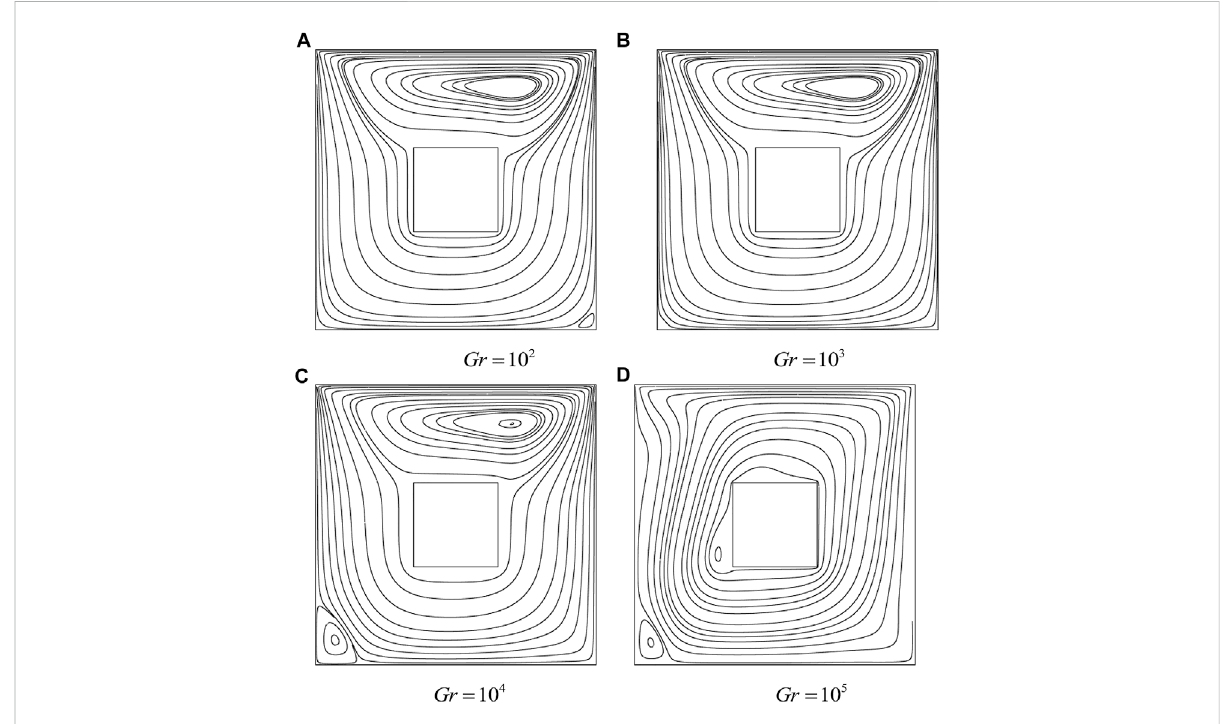
FIGURE 3 In fl uence of Gr on streamlines with a uniform heated bottom wall: cold cylinder case, Ha (cid:2) 20 and Re (cid:2) 100.